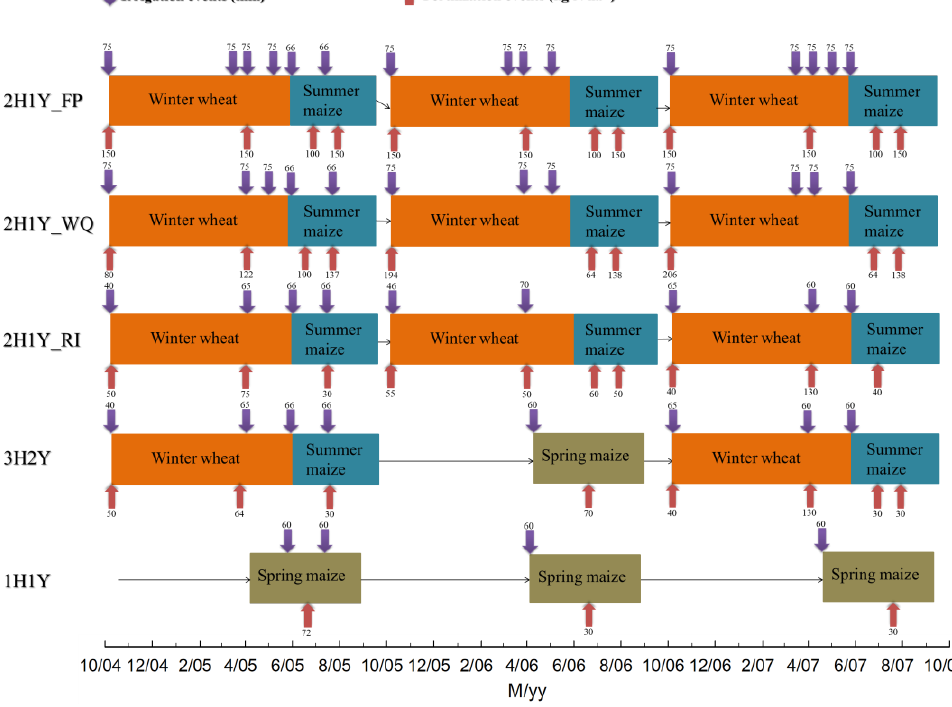
Figure 1. Crop rotations and water and N inputs for five different cropping systems. Note: 2H1Y_FP— two harvests in one year of farmer’s practice; 2H1Y_WQ—two harvests in one year of the Wuqiao pattern; 2H1Y_RI—two harvests in one year of the reduced input; 3H2Y—three harvests in two